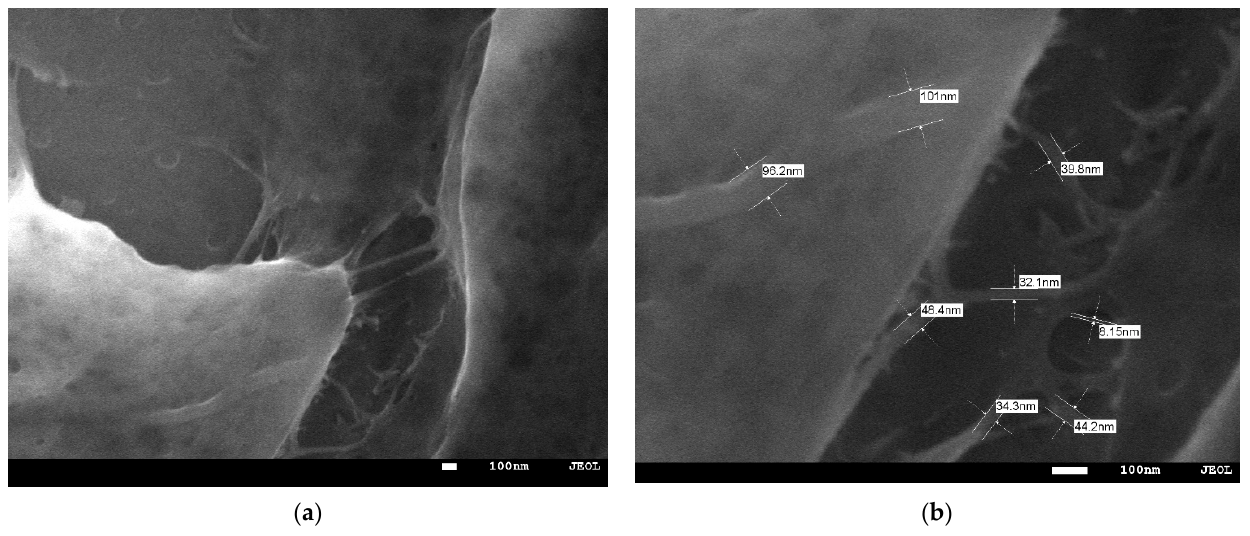
Figure 3. SEM images of CNF(Et): ( a ) nanocellulose structure; ( b ) diameters of cellulose fibres.